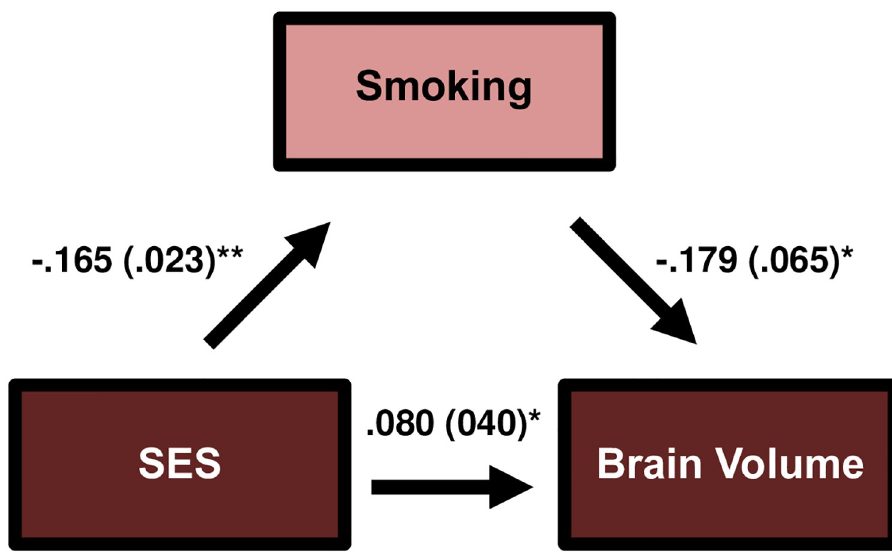
Fig 1. Smoking mediates SES and brain